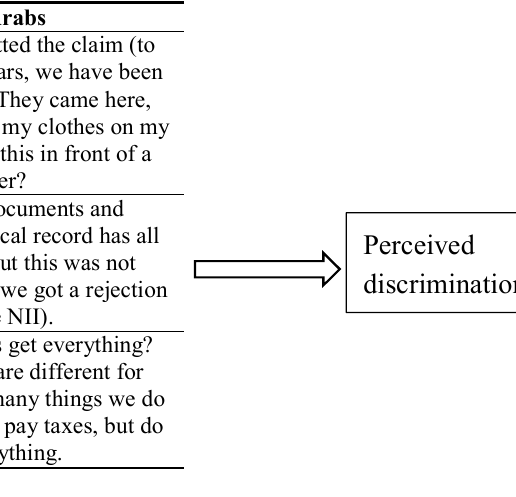
Table 2. An example of the coding scheme used in the present study and the transition from codes to themes.